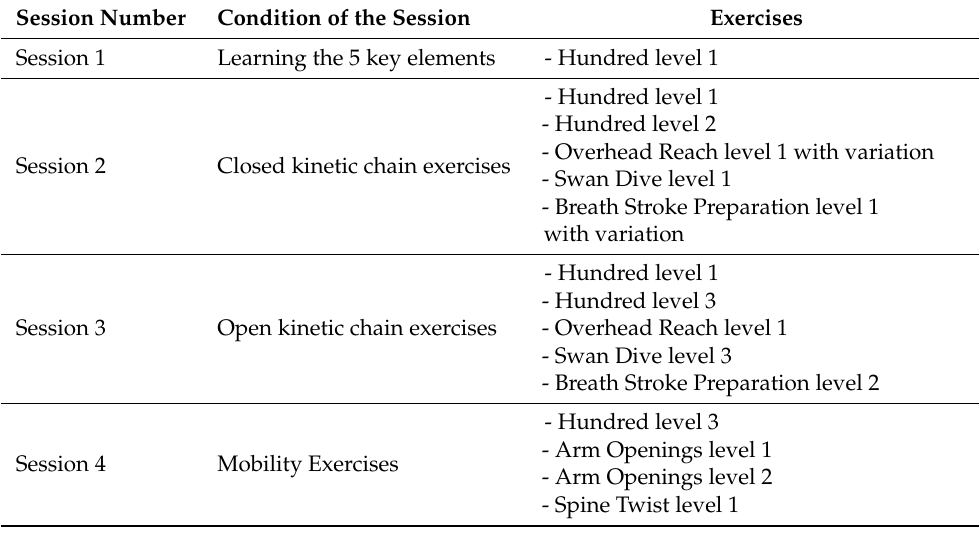
Table 1. Condition and exercises related to each session of the